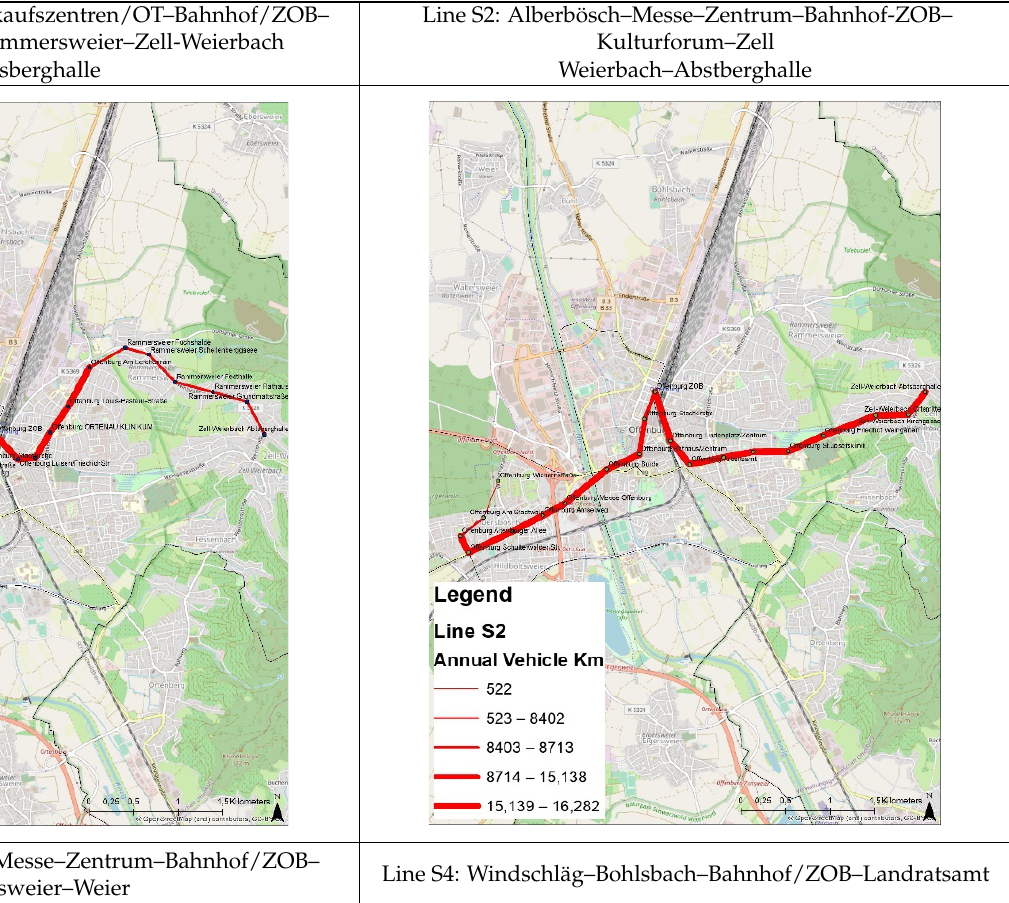
Table A1. Structure analysis for bus lines in Offenburg: the city bus lines (S1 to S9) and the regional lines (R106,